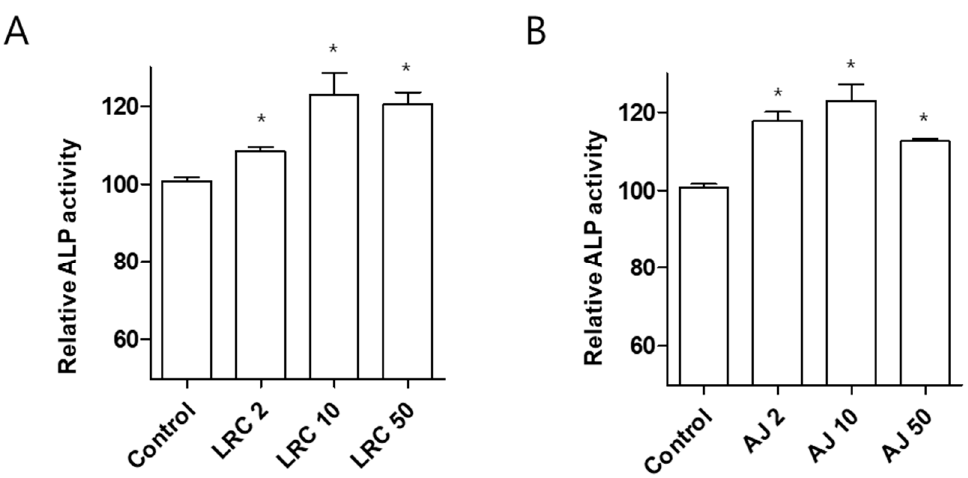
Figure 1. Effects of LRC and AJ extracts on cellular differentiation of the osteoblast-lineage cell line MC3T3-E1. Assessment of alkaline phosphatase (ALP) activity is shown for LRC ( A ) and AJ ( B ) extracts in MC3T3-E1 osteoblastic cells. After induction of osteoblast differentiation with 50 μ g/mL of ascorbic acid and 10 mM of β -glycerophosphate, cells were cultured with three different concentrations (2, 10, and 50 μ g/mL) for 3 days, and alkaline phosphatase (ALP) activity was analyzed. *: p < 0.05 vs. Control.